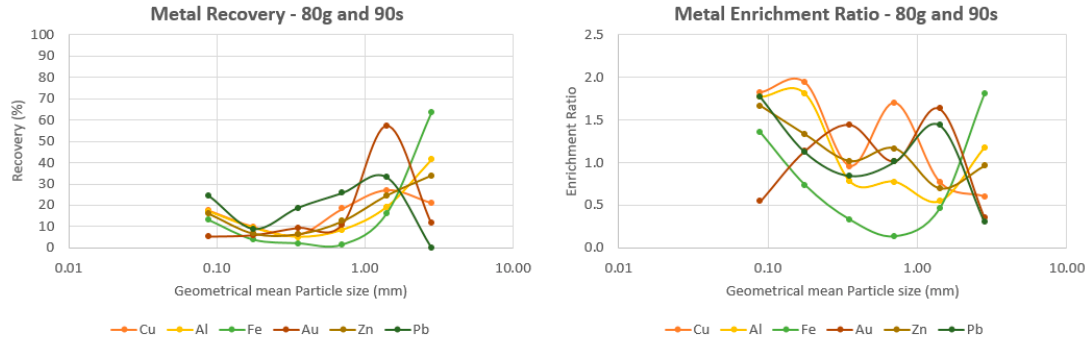
Figure 12. ( a ) Metal recovery and ( b ) Metal enrichment ratio after hammer milling as a function of feed mass, milling time and particle size. Feed particle size fraction was 2–4 mm. The feed mass was 80 g and milling time was 90 s. Experimental data points are connected with lines for the purpose of visual aid only.